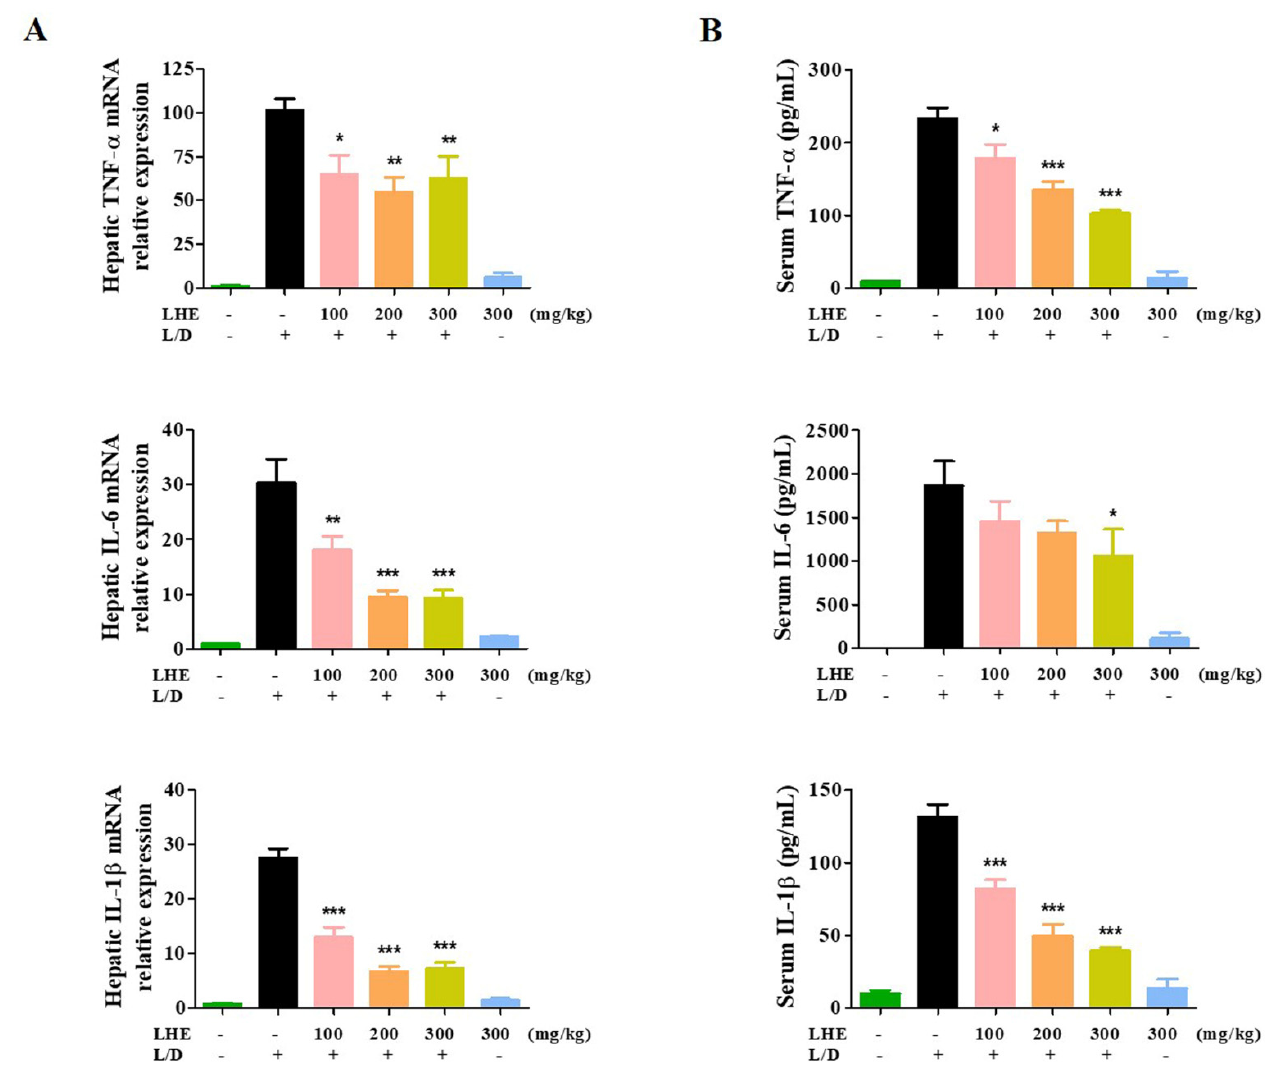
Figure 4. Effects of LHE on ( A ) the expression of hepatic cytokine mRNA and ( B ) serum cytokine levels in LPS/D-GalN- induced hepatitis mouse model. Mice were pretreated with LHE or vehicle once per day for 6 days. Then, LPS/D-GalN was injected 1 h after the last administration. After 6 h, blood samples were collected from the abdominal vena cava puncture, and serum was prepared via centrifugation. ( A ) The mRNA levels of hepatic cytokine were analyzed via qPCR. ( B ) Serum cytokine levels were determined via ELISA. Data were expressed as mean ± SEM ( n = 9). * p values of < 0.05, ** < 0.01, and *** < 0.001 (vs. LPS/D-GalN) were considered statistically significant.